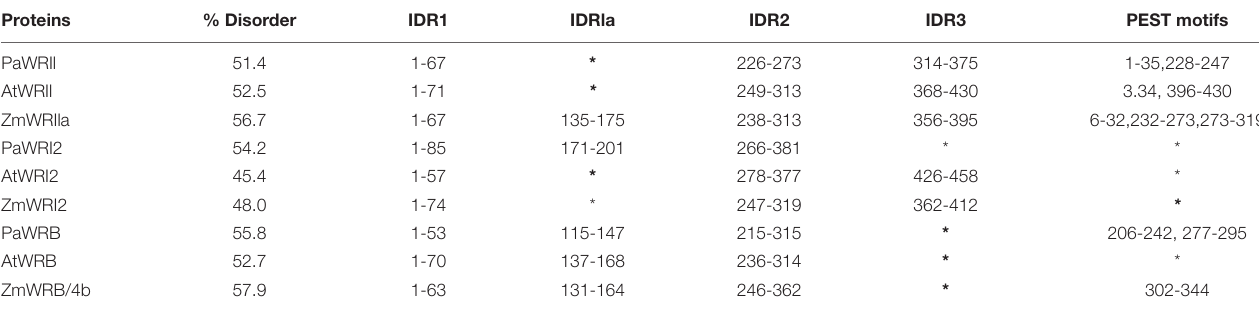
*Indicates the absence of the corresponding IDR or PEST motif.